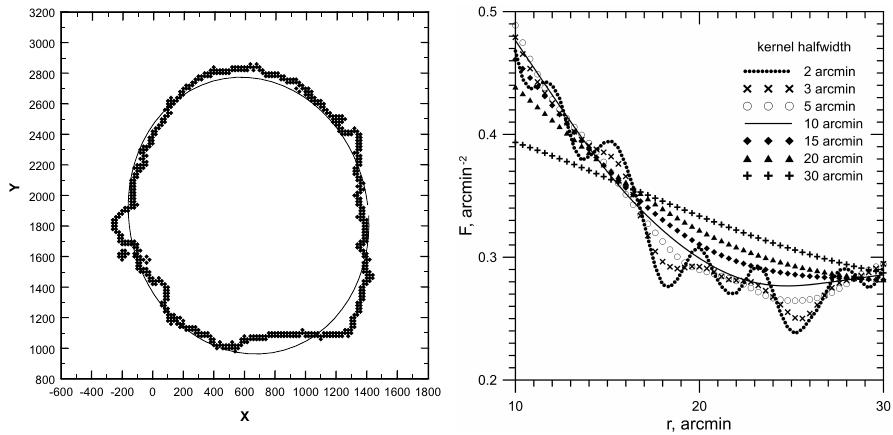
Fig. 2. Left-hand panel : approximation of the density contour by an ellipse. The solid circles show the density grid points closest to the selected contour. Right-hand panel : selection of the optimum kernel halfwidth for the open cluster NGC 2287, J lim = 13 mag. along the cluster